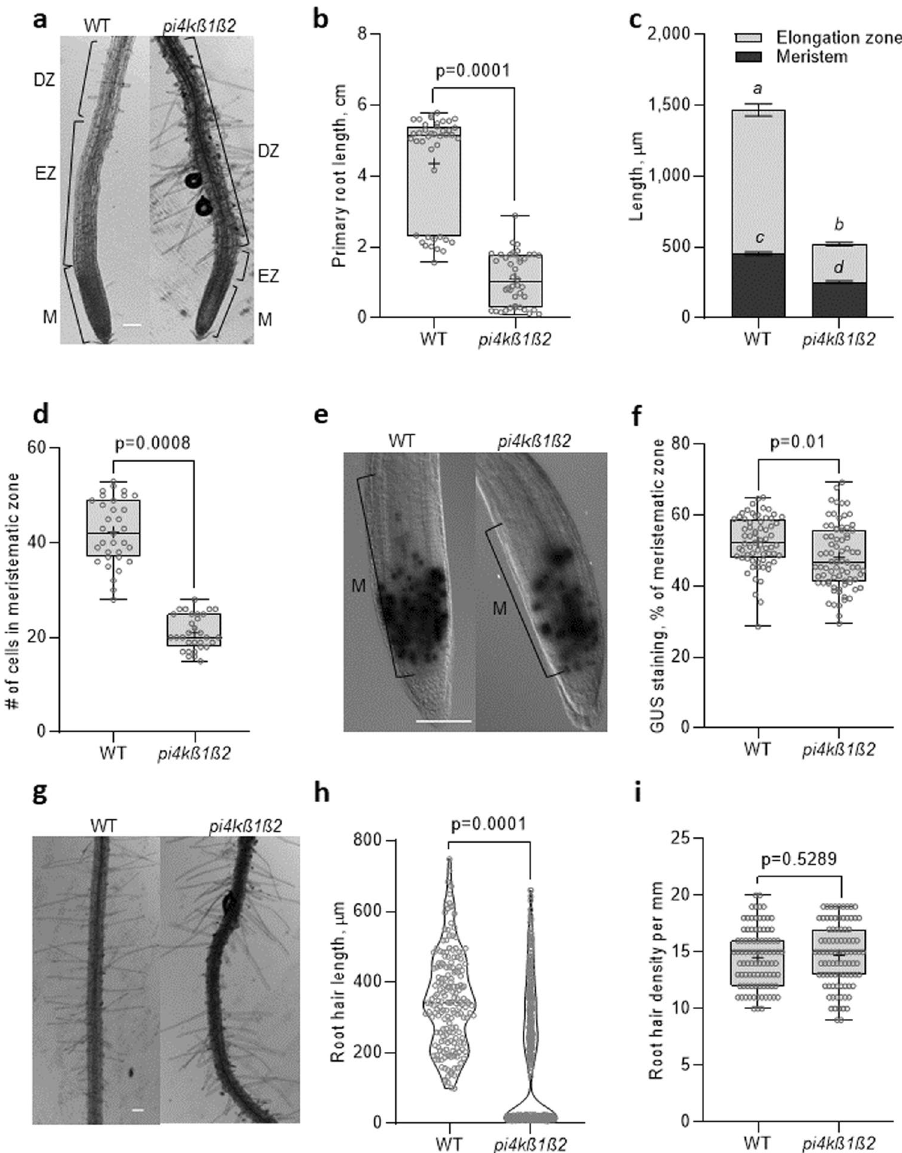
Figure 1. Impaired root growth and morphological characteristics of the pi4kß1ß2 mutant. ( a ) representative pictures of the apical root parts of 11-day-old seedlings of Arabidopsis thaliana Col-0 (WT) and the pi4kß1ß2 mutant: meristem (M), elongation zone (EZ) and differentiation zone (DZ) are marked, scale bar = 100 μm; ( b ) primary root length, n = 40; ( c ) length of the meristematic and elongation zones, n = 12, error bars represent mean ± SEM; different letters indicate statistically significant groups, one-way ANOVA with Tukey-HSD post- hoc test (p > 0.05); ( d ) number of separated cells in the meristem, n = 36; ( e ) representative images of GUS staining in the root meristem of 4-day-old plants expressing CycB1::GUS, scale bar = 100 μm; ( f ) relative area of CycB1::GUS expression, % of the meristematic zone; n = 72; ( g ) representative images of root hair distribution in the DZ of roots, scale bar = 100 μm; ( h ) root hair length, n = 180; ( i ) root hair density, n = 90. Central line of the boxplots represents the median, plus represents the mean, circles represent individual values from three biological repeats. p -value was calculated by Student